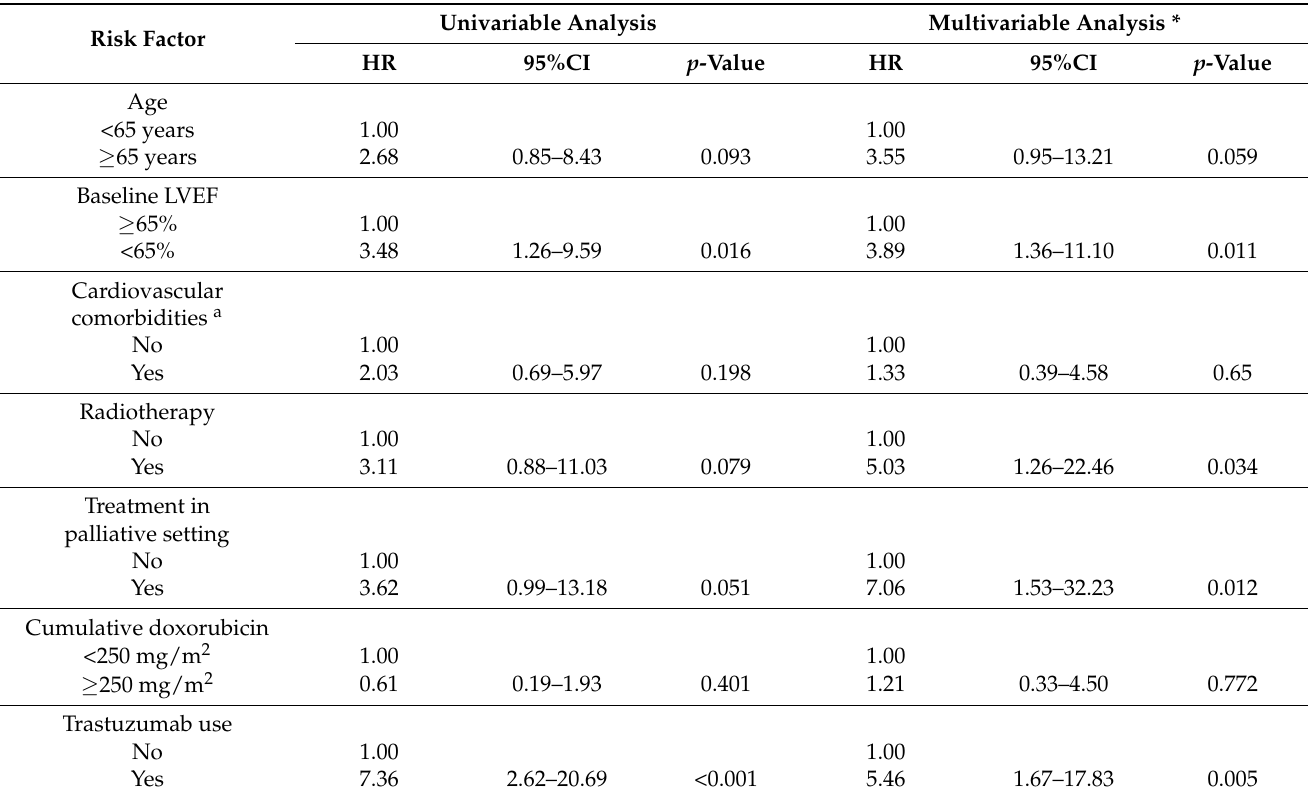
Table 3. Univariable and Multivariable analysis of risk factors associate with HF ( n = 475). Risk